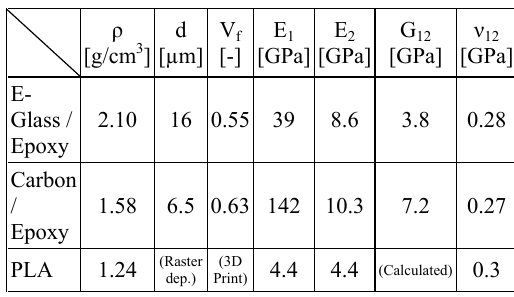
Table 2: Typical lamina properties for different